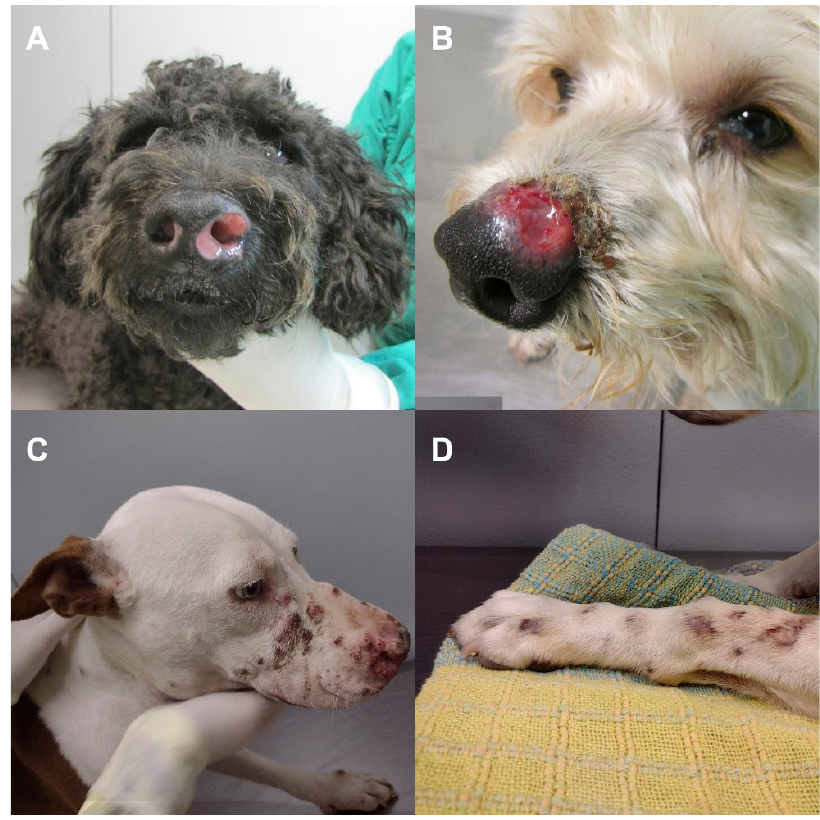
Figure 1. Clinical presentations of canine sporotrichosis. ( A ) Nasal mucosal lesions (mucosal form); ( B ) ulcer and meliceric crusts on the nose (localized/fixed cutaneous form); ( C ) multiple skin lesions partially covered by hematic crusts on the cephalic region and the left forelimb (disseminated cuta- neous form); and ( D ) ascending nodular lymphangitis on the left forelimb (lymphocutaneous form).